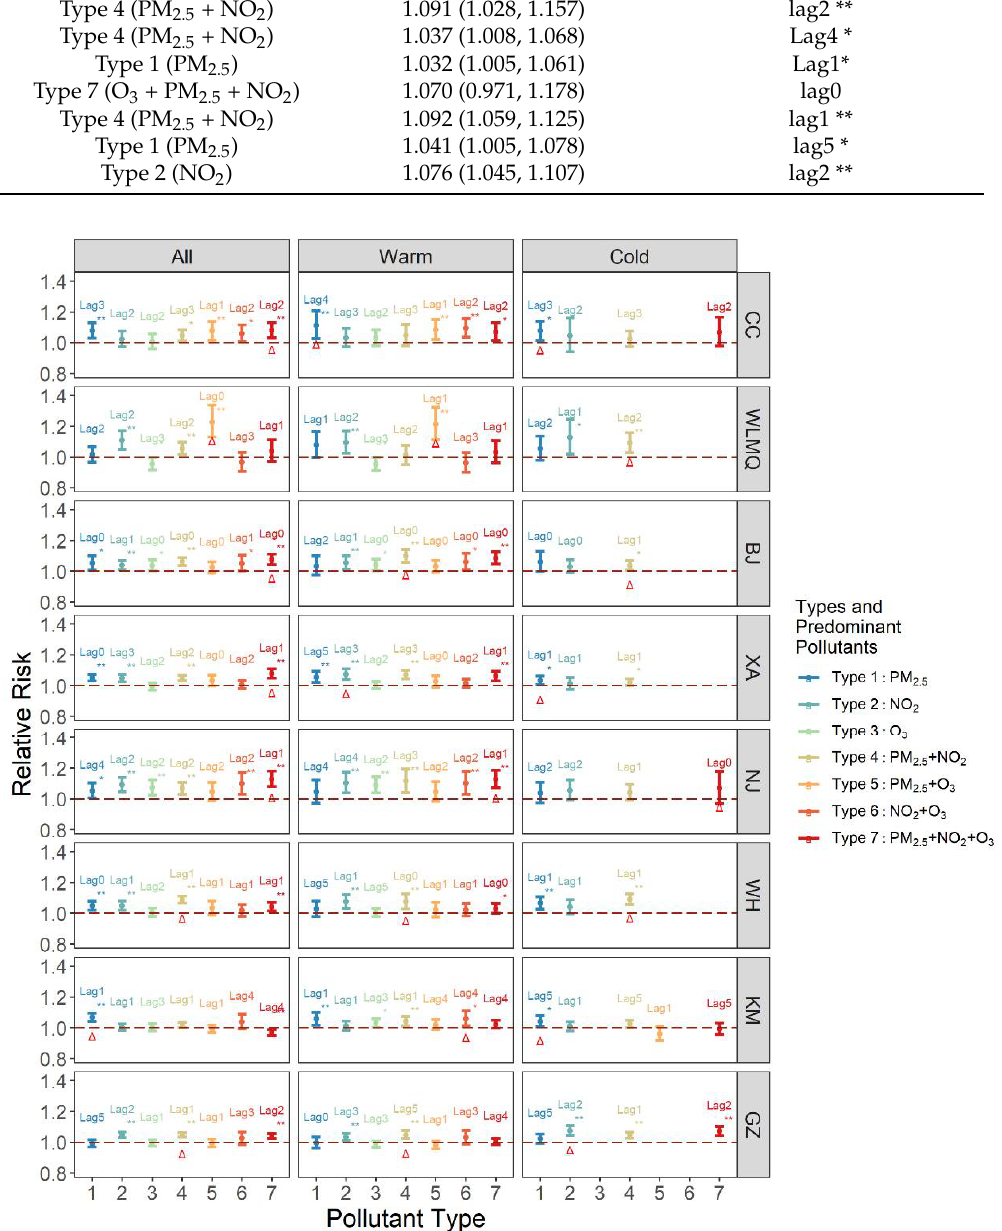
Figure 2. Association between different pollution types and RRs (95% CIs) of mortality modified by season. Among them, types 1–3 are high single-pollutant types, and types 4–7 are high multi-pollutant types. Considering the lag of lag0 to lag5, the day with the highest RR value of each type was selected for analysis and comparison, and the lag day was marked above the corresponding type. The red triangle is indicated as the type with the highest RR, and the results that pass the significance test are preferentially selected. The eight cities are arranged north to south by latitude from top (CC) to bottom (GZ). * p < 0.05, ** p < 0.01. Table 4. The pollution type with the highest lag of 0–5 days and their corresponding risk values and lag days in 8 cities. Pollutants at high levels are listed in parentheses (Annual). ** p < 0.01. The Pollution Type with the The Highest RR (with City Lag Highest RR (Annual) 95% CIs) Changchun Type 7 (O 3 + PM 2.5 + NO 2 ) 1.080 (1.032, 1.131) lag2 ** Urumqi